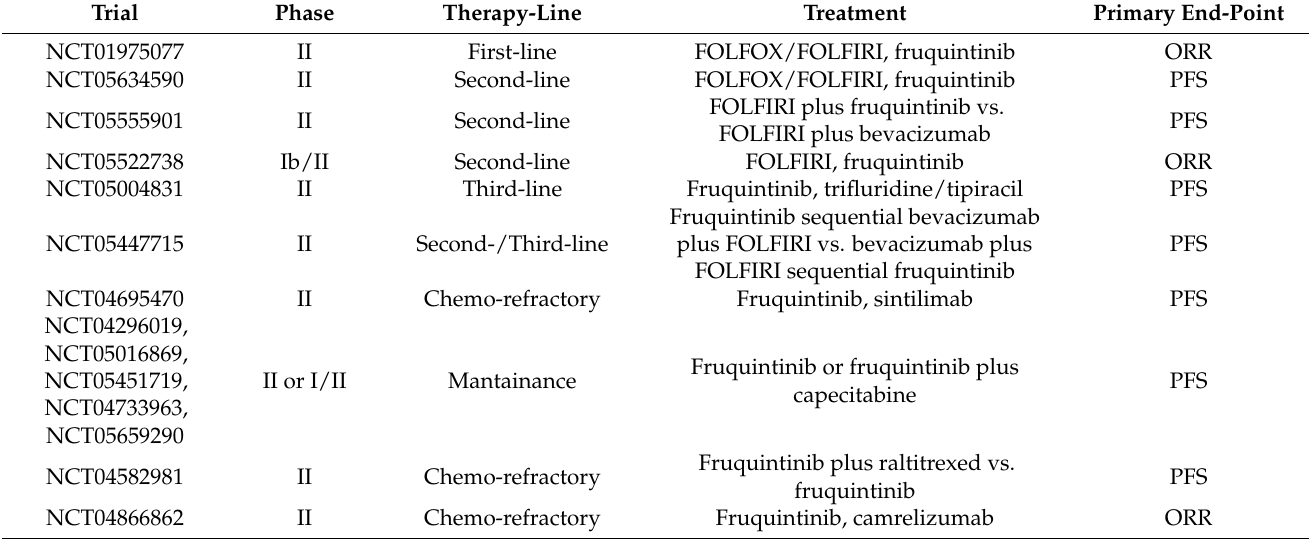
Table 2. Summary of the main ongoing trials of fruquintinib in colorectal